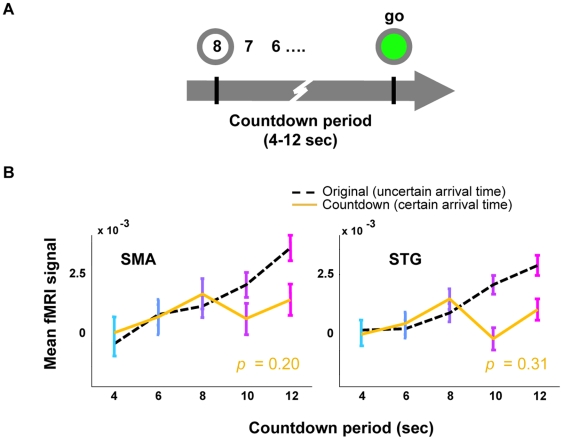
The post-go fMRI signal no longer correlates with the waiting period when there is certainty about the arrival time of the go cue.(A) In the countdown condition, a number in the middle of the gray ring counted down the seconds until the appearance of the go signal. (B) When there is no uncertainty about the arrival time of the go signal, the fMRI signal is independent of the readiness period (solid line, p-values of the correlation, inset). For comparison, the dashed line represents the fMRI signal in the original experiment (Figure 1), in which there is no countdown. Error bars SEM.